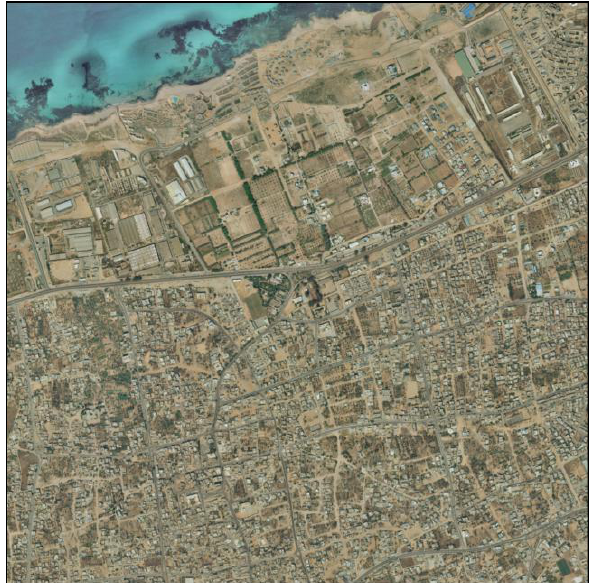
Figure 5. Aerial photograph covering one of the Metro planning